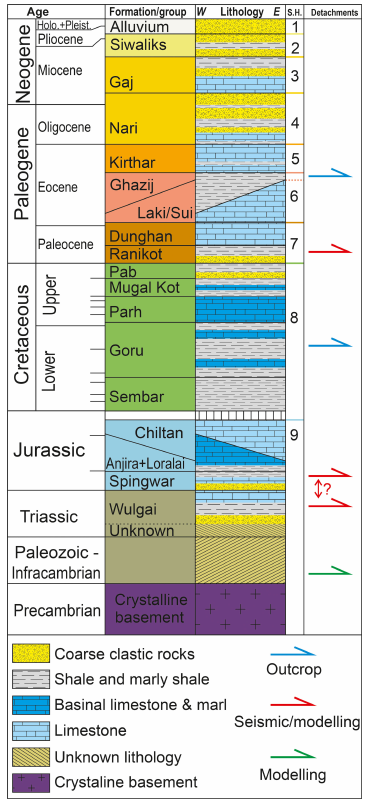
Figure 4. Lithostratigraphic overview with mechanical stratigraphic interpretations (after Kadri, 1995; Tectostrat, unpublished, 2001; Smewing et al., 2002b; and author observations). S.H.: seismic hori- zons used in this study.